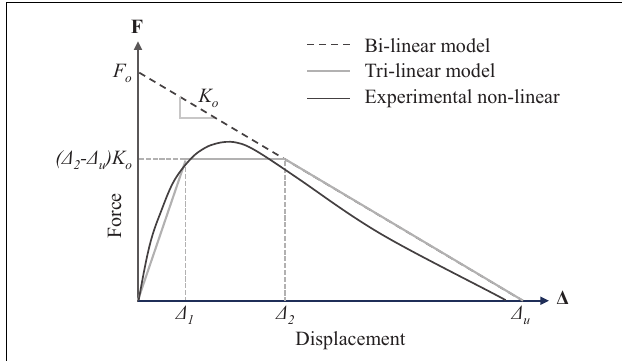
FIGURE 6 | Force-displacement relationship for out-of-plane. Adapted from Doherty (2000) with permission from K. Doherty.